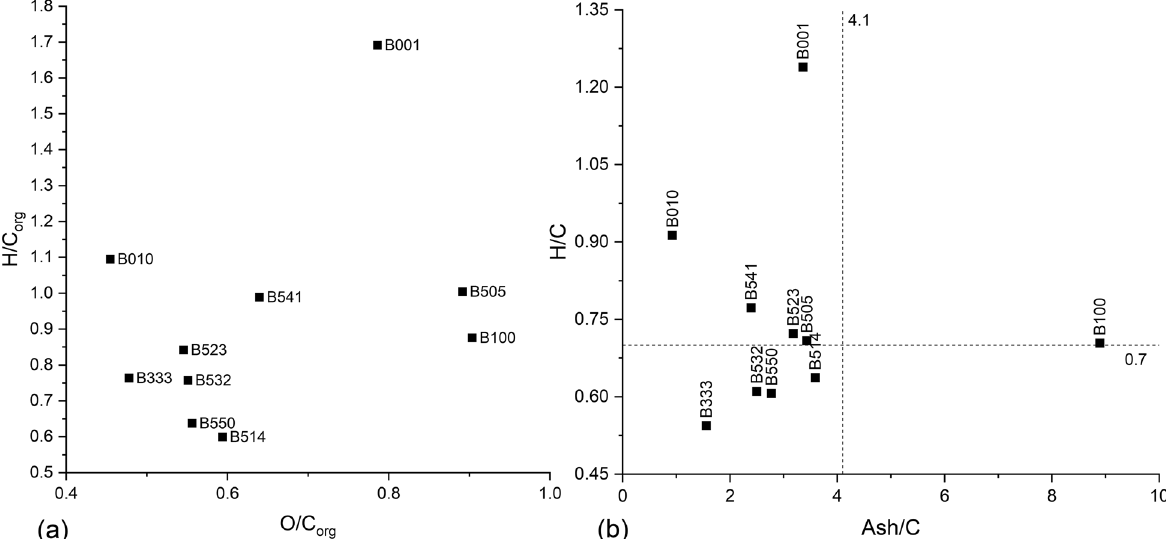
Fig. 2 A van Krevelen diagram ( b ) of the biochar types under study; and plot of H/C vs Ash/C ( a ) showing mineral and ash-rich biochar (MAB) defined by H/C ⩽ 0.7 and Ash/C ⩽